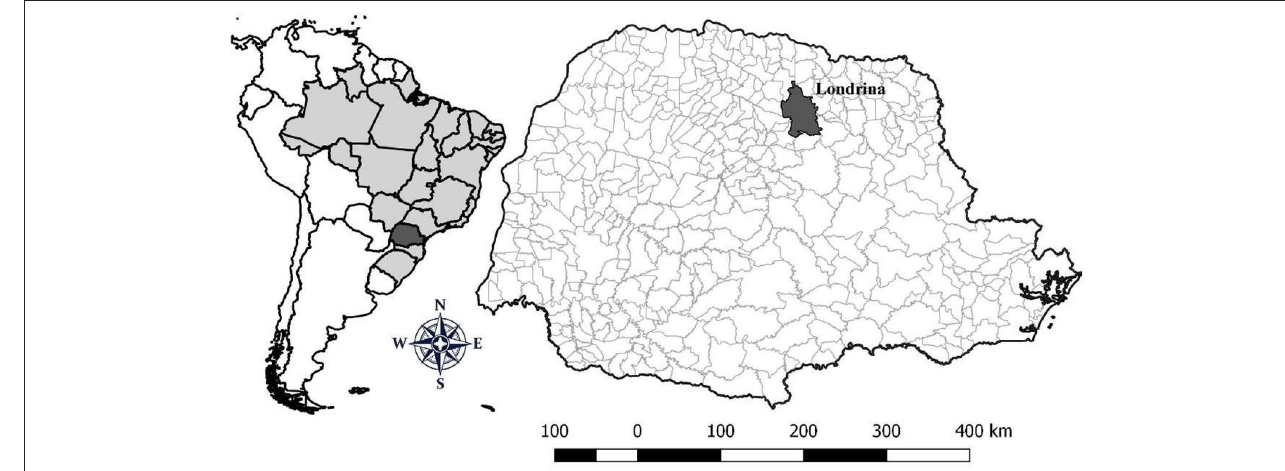
FIGURE 1 | Overview of the experimental site in Londrina County, Paraná State, Brazil.